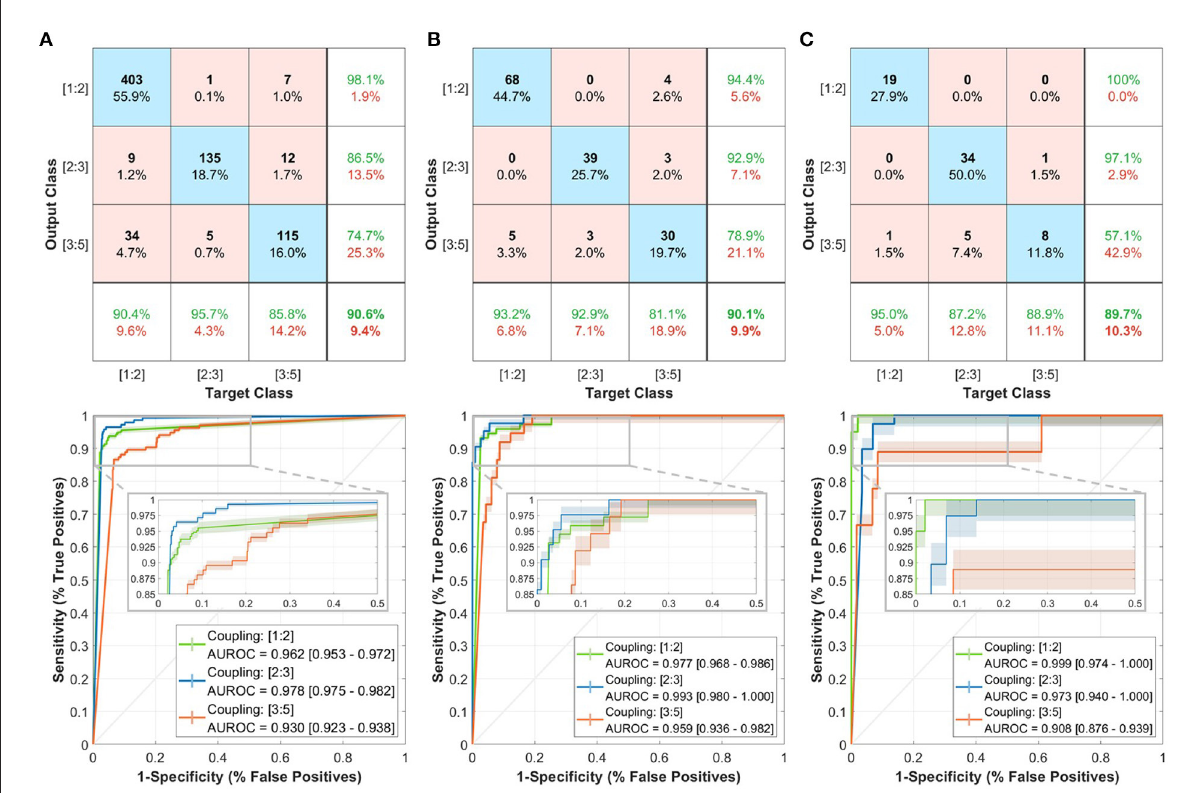
FIGURE2 Performance of the trained deep learning model in predicting the three coupling scenarios including confusion matrices (top row) and receiver operating characteristics (ROC) curves (bottom row). (A) Training set. (B) Local testing set. (C) PhysioNet testing set. In the confusion matrix, the bottom row shows the sensitivity, right column shows the precision, and bottom-right corner the overall accuracy. Each of the ROC curves includes a shaded region to represent the 95 % confidence interval (CI). A zoomed-in view of the ROC curves shows the interval of more than 50 %